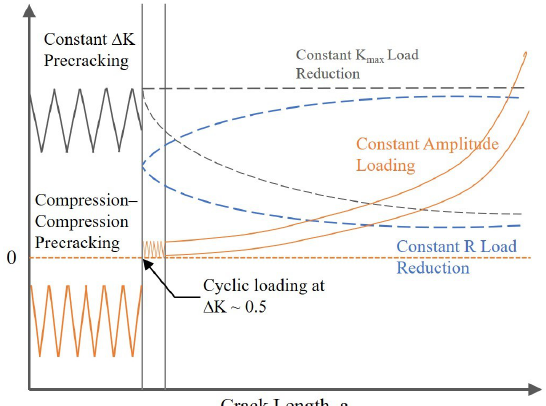
Figure 12. Fatigue threshold test methods compared in the work of Forth et al. [25]: (1) constant K max load reduction, (2) constant R load reduction, and (3) constant amplitude loading.